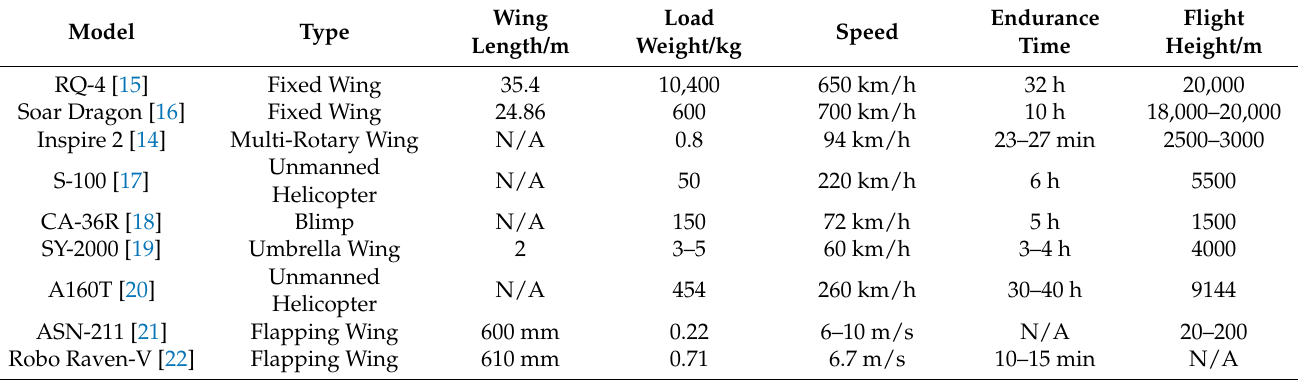
Figure 1. Classification of UAVs. Reprint with Academic Open Access [6–11]; 2021; Wikimedia. Table 1. Characteristics of different wing-type UAVs.